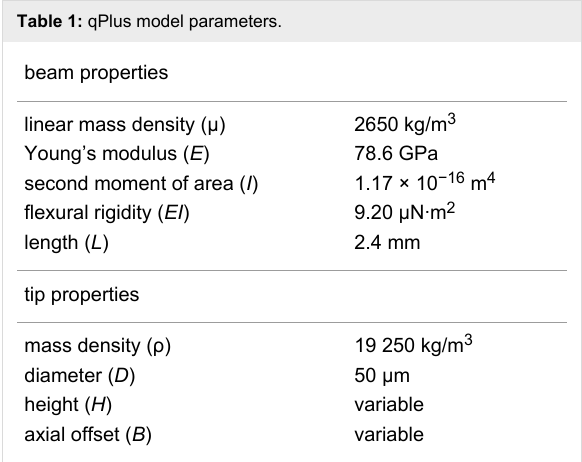
Table 1: qPlus model